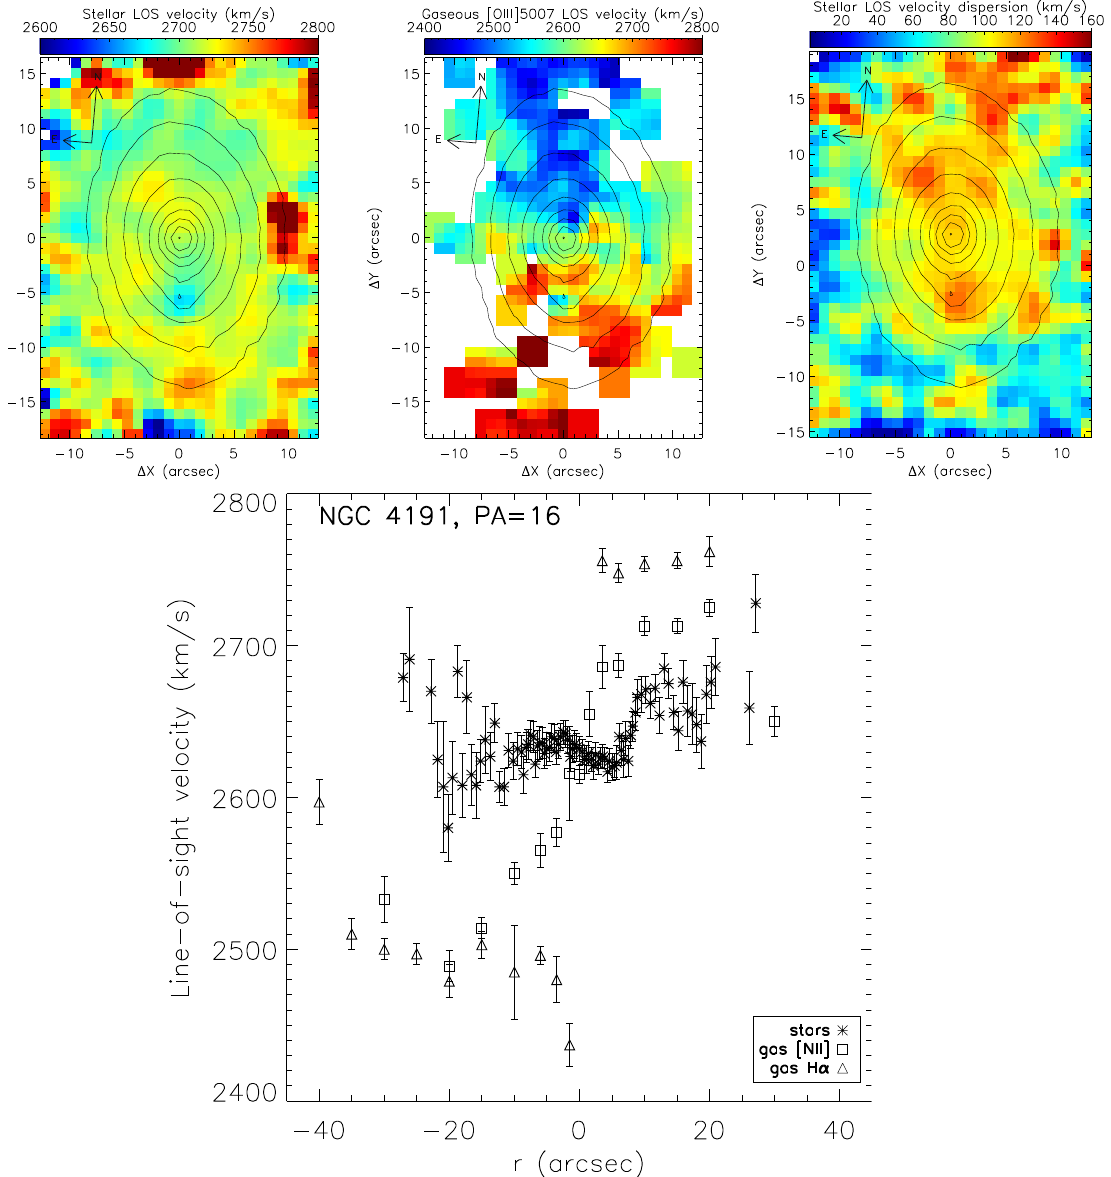
Figure 2. Kinematical data for the S0 galaxy NGC 4191—member of the Virgo cluster. The upper row presents the panoramic spectral data obtained with the IFU SAURON: the LOS velocity field of the stellar component, the ionized-gas ([OIII] λ 5007) LOS velocity field, the map of the stellar velocity dispersion. The bottom plot shows the long-slit cross-section close to the major axis, in PA = 16 ◦ , made with the reducer SCORPIO-2 [35] of the Russian 6m telescope in the long-slit